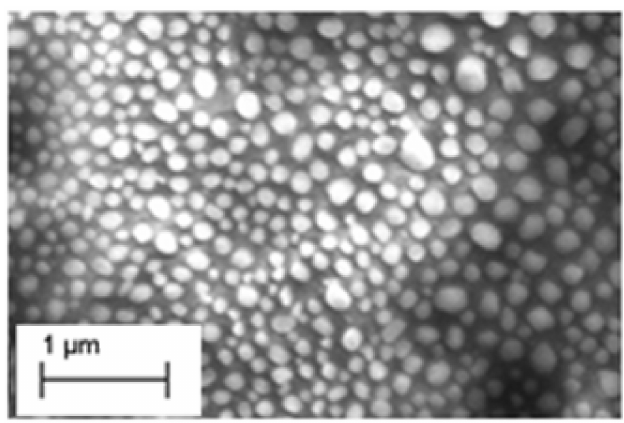
Figure 2. SEM image of cross-linked P(NIPAM-co-2%AMPS) nanop. articles deposited onto a glass slide. Taken in low-vacuum mode without